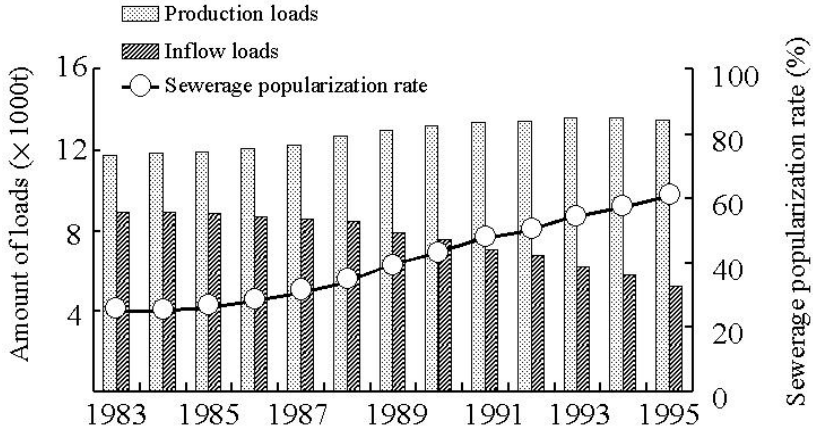
FIGURE 2 . Change of popularization of sewerage and amount of